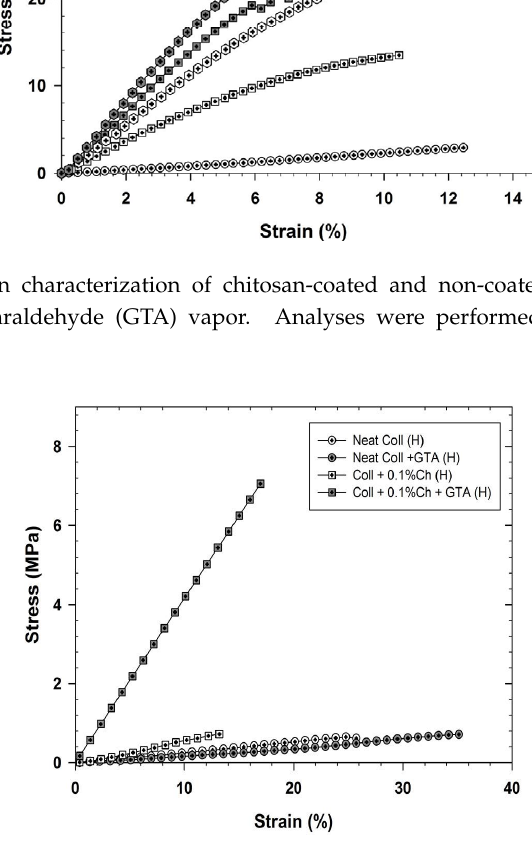
Figure 5. Stress ‐ strain characterization of chitosan ‐ coated and non ‐ coated collagen membranes crosslinked with glutaraldehyde vapor. Analyses were performed on humidified (H) membranes. In our opinion, membrane flexibility under wet conditions could be an advantage when used for cartilage